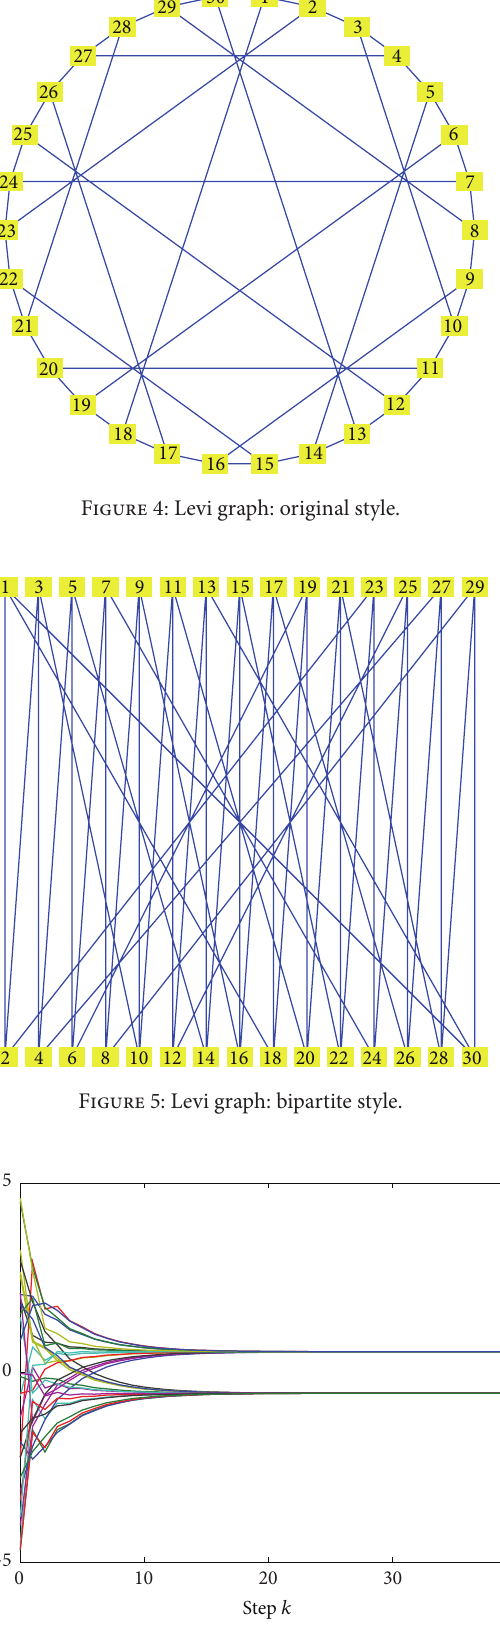
Figure 6: The histories of 𝑥 𝑖 (𝑘) , 𝑖 = 1, 2, .. ., 30